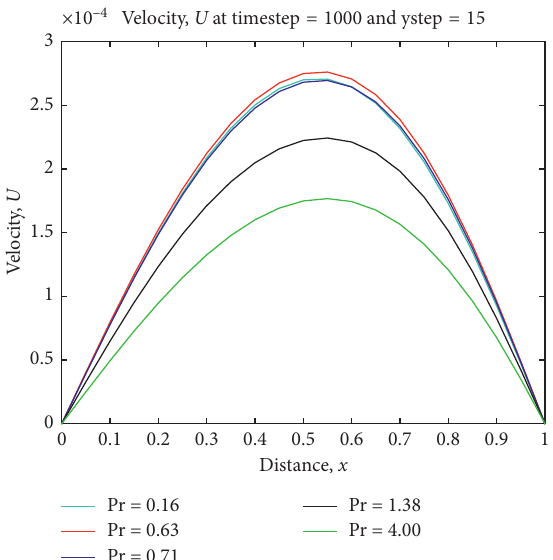
Figure 5: Graph of effects of the Prandt number on primary velocity profile u